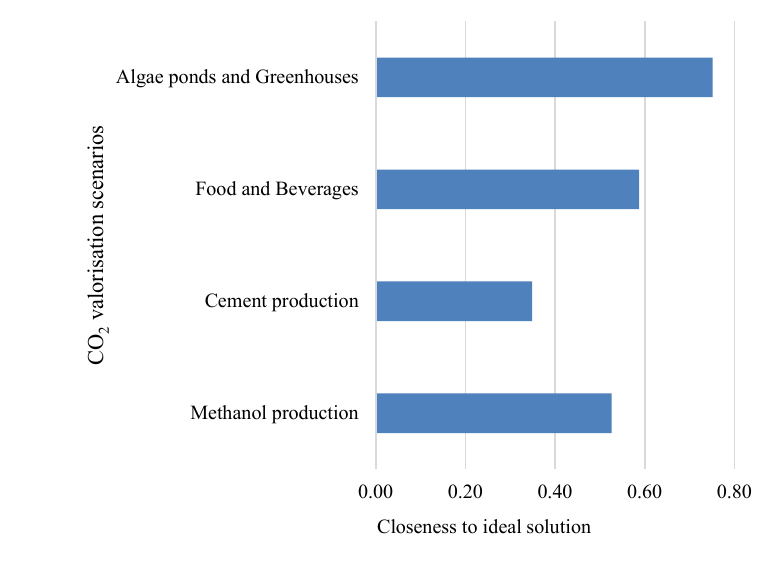
Fig. 5. CO 2 valorisation MCDA